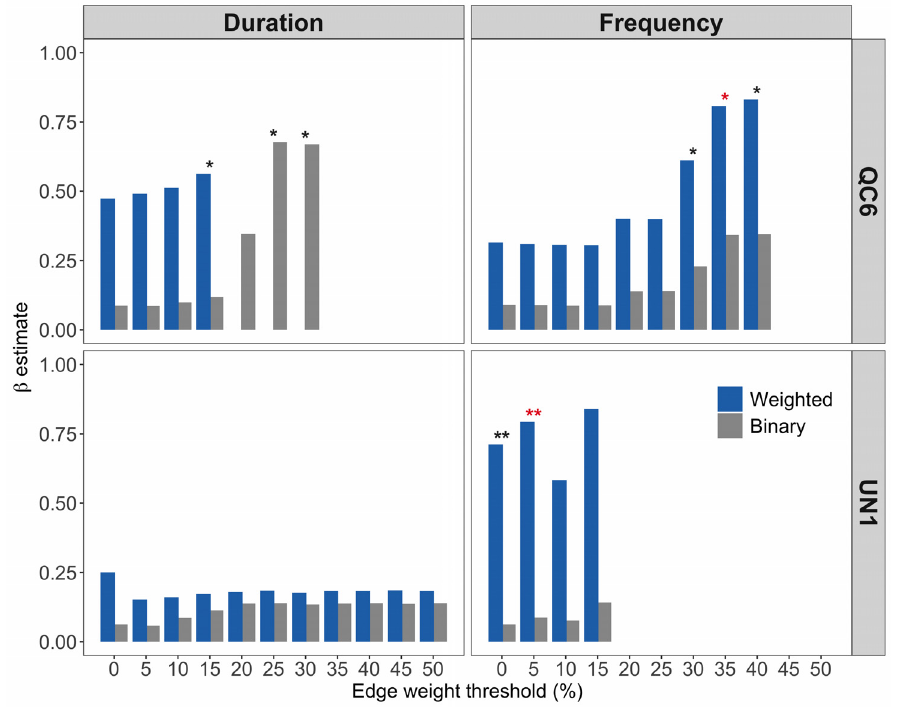
Fig 5. Identifying the contact network model of Crithidia spread in two bumble bee colonies (QC6 and UN1) described in [36]. Edges in the contact network models represent physical interaction between the bees. Since the networks were fully connected, a series of filtered contact networks were constructed by removing weak weighted edges in the network. The x-axis represents the edge weight threshold used to remove weak edges in the network. Two types of edge weights were tested—duration and frequency of contacts. In addition, both types of weighted edges were converted to binary to create binary networks. The results shown are estimated values of the per contact rate transmission rate, β , for the two colonies. Asterisks above bars indicate that the networks were epidemiologically relevant in explaining the spread of Crithidia (single asterisk: Log ( B 10 ) = 0.5–1, substantial evidence; double asterisks: Log ( B 10 ) = 1–2, strong evidence). We note that model convergence was not achieved for several network hypotheses and were removed in our final